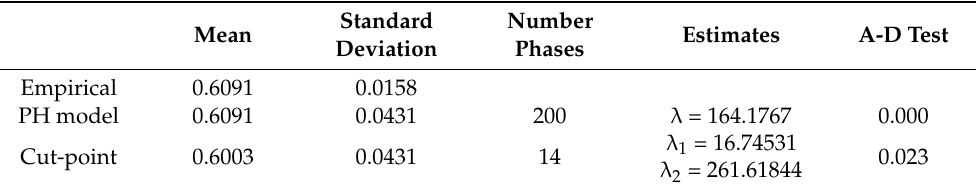
Table 1. Comparing measures between models for reset voltage.